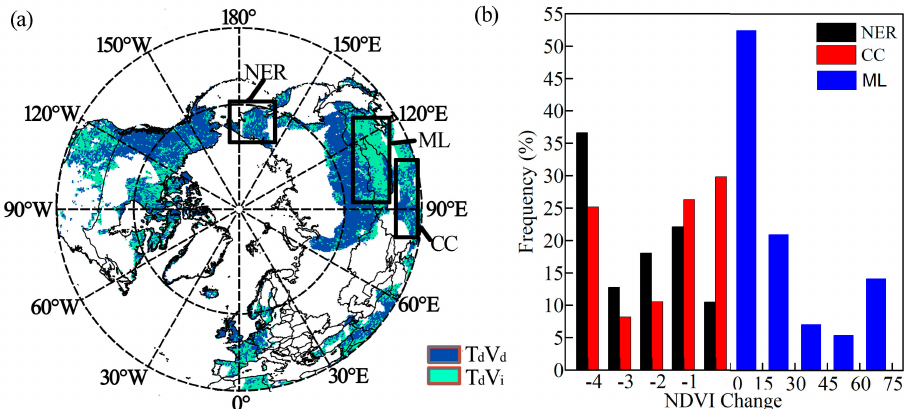
Figure 3. Spatial distribution of regions with a warming hiatus. NER: northeastern Russia; ML: Mongolia; CC: central China; ( a ) spatial distribution of a warming hiatus in the middle-high latitudes of the NH; ( b ) frequency distribution of the NDVI proportion in all regions. T d V d indicates a decrease in the NDVI in conjunction with the warming hiatus; T d V i indicates an increase in the NDVI in conjunction with the warming hiatus.